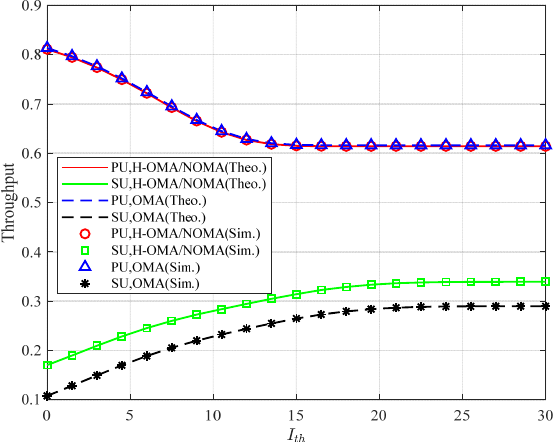
Figure 10. Throughput vs interference threshold ( 𝐼 (cid:3047)(cid:3035)